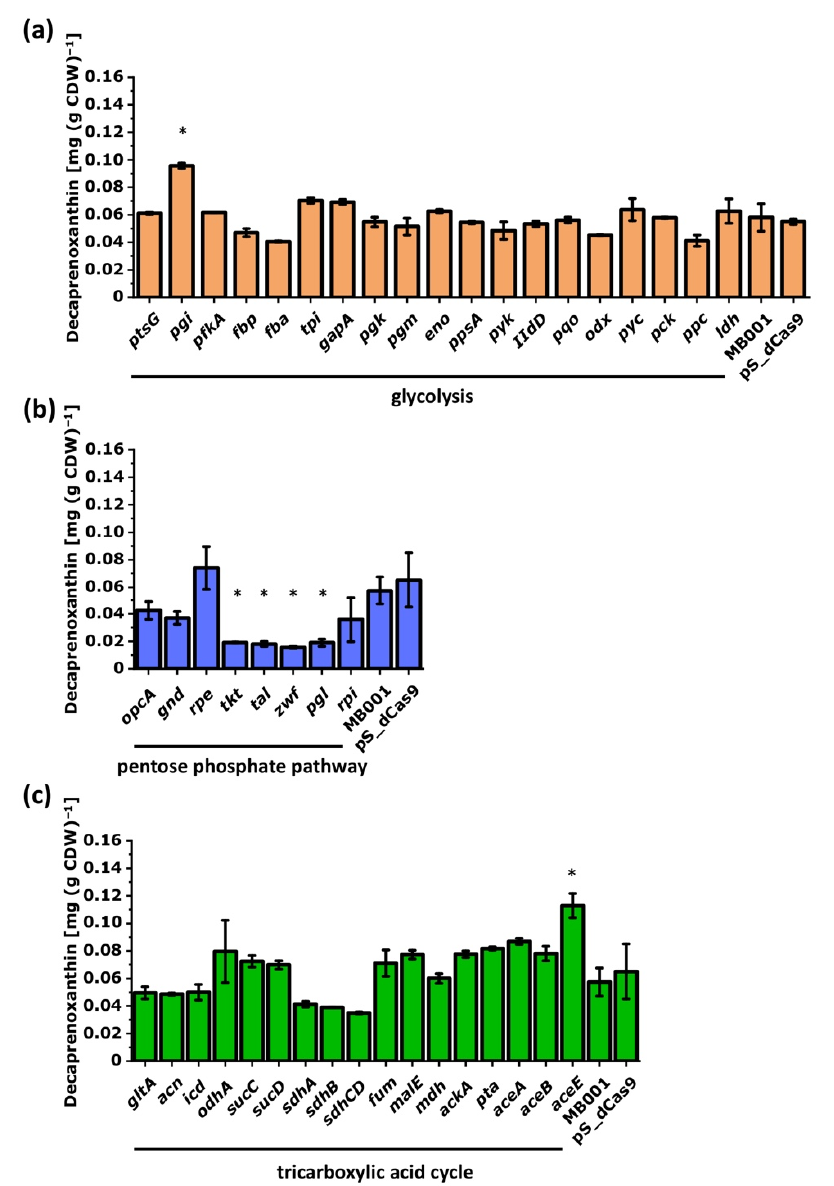
Figure 7. Influence of CRISPRi-mediated repression of genes of glycolysis ( a ), the pentose phosphate pathway ( b ), or the TCA cycle and glyoxylate shunt ( c ) on decaprenoxanthin biosynthesis. Mean values of biological duplicates are given. Statistical analysis was calculated with ANOVA against all measured decaprenoxanthin production of C. glutamicum MB001 from all Biolector ® flowerplates and is marked by a star (*). As a reference, the decaprenoxanthin production of the empty vector strain C. glutamicum MB001 (pS_dCas9) in biological duplicates of the corresponding experiment is shown. For abbreviations, see Figure 3.